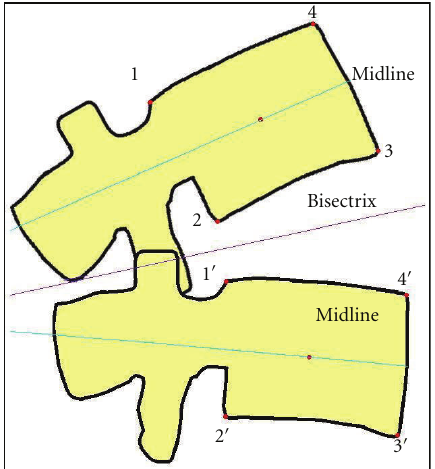
Figure 3: Frobin et al.’s [36] method for registering the positions of